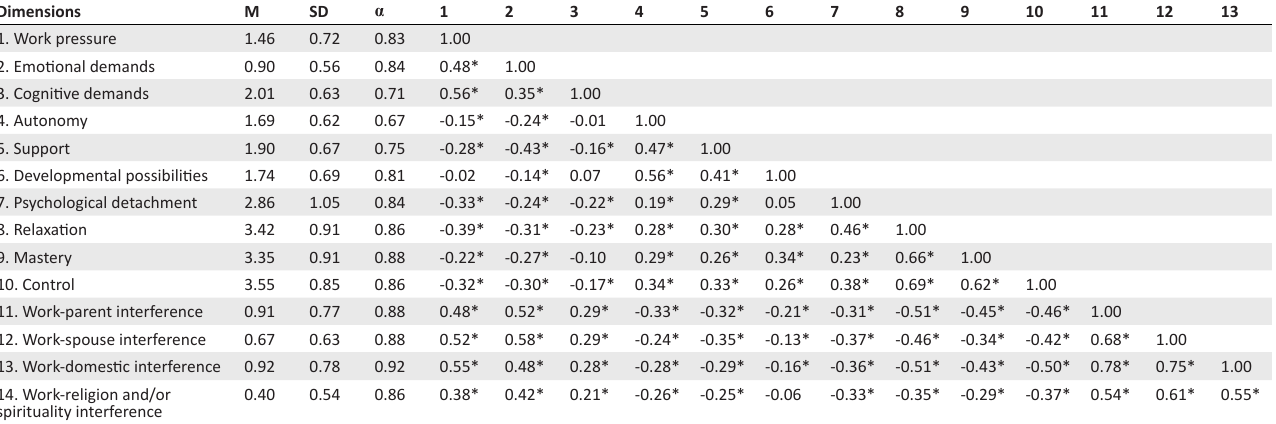
TABLE 1: Correlation coefficients between job demands, job resources, recovery experiences and work-nonwork interference. Dimensions